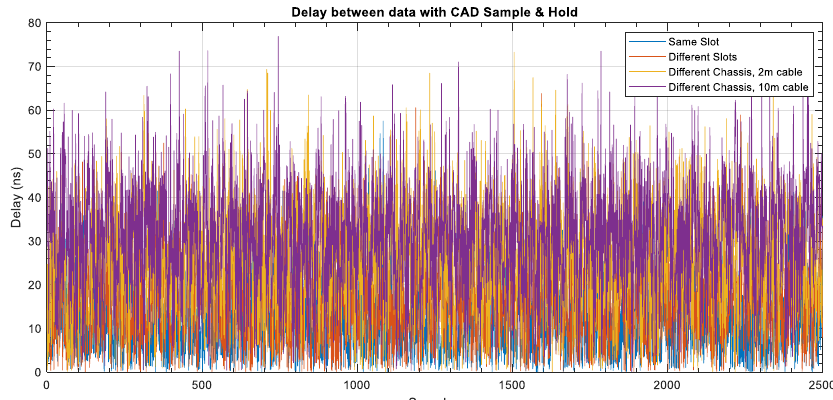
Figure 10. Time series of the four SAR converter tests.